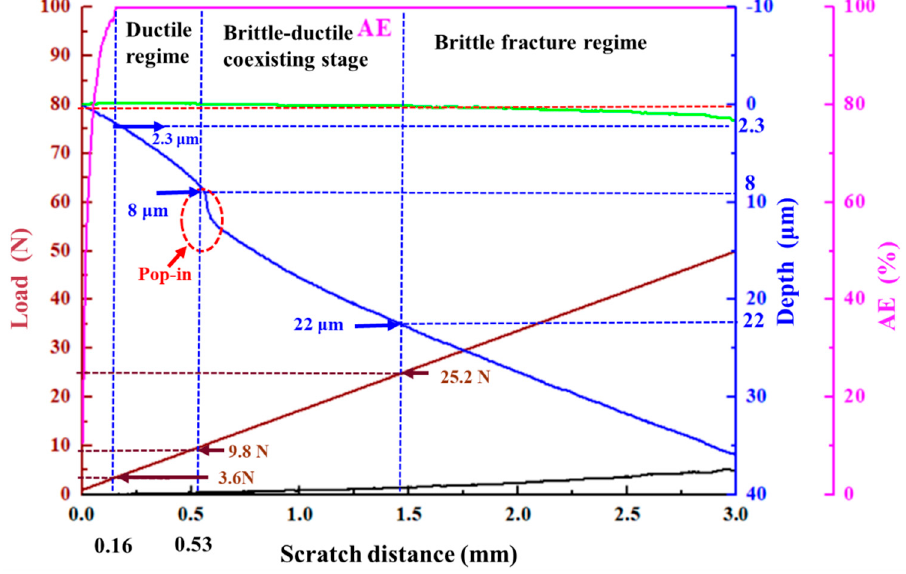
Figure 5. Main load-displacement curves of the scratching experiment (1–50 N loading).